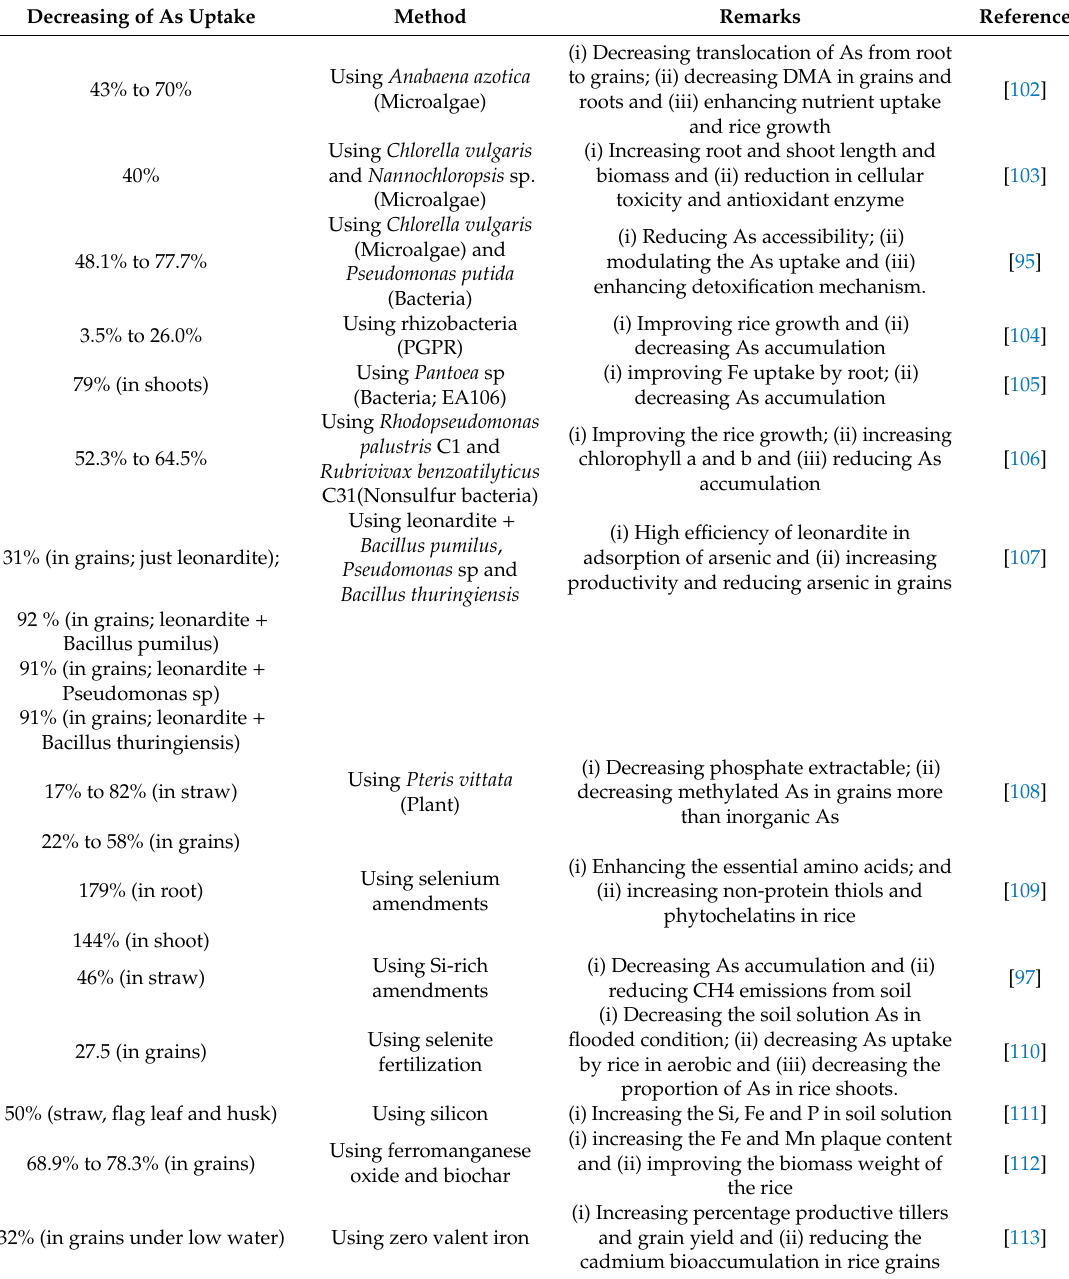
Table 3. Reported ways for reducing the uptake of As by rice